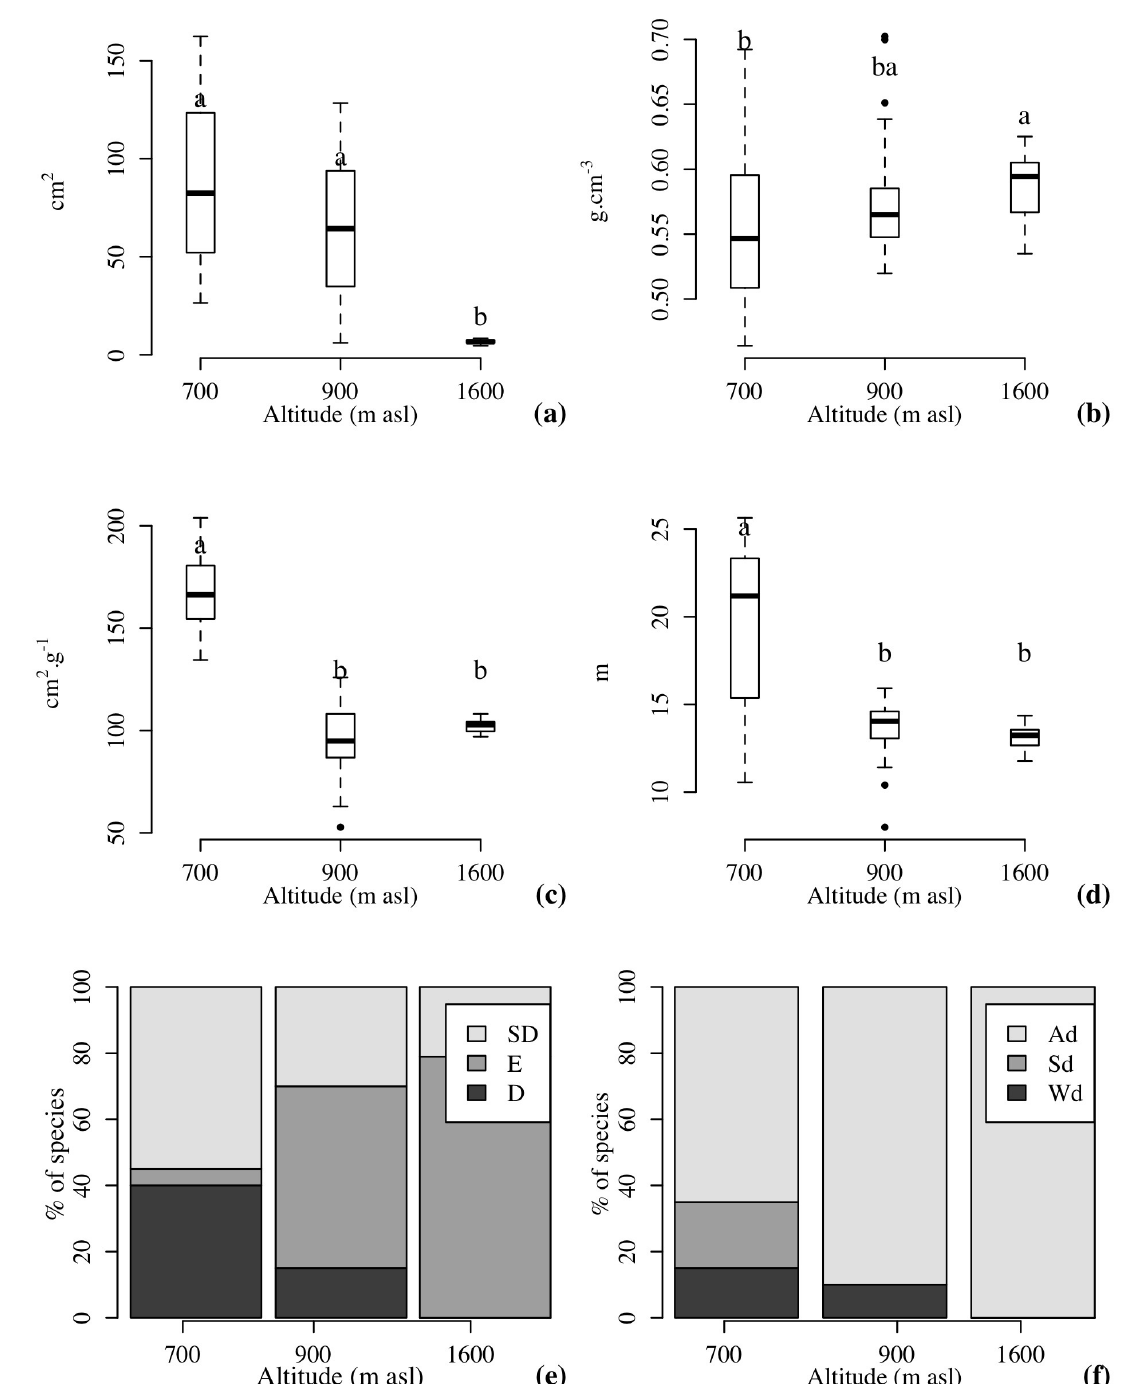
Figure 3 - Comparison of functional traits of tree species ( a - Leaf Area; b - Basic Wood Density; c - Specific Leaf Area; d - Maximum Potential Height; e - Pattern of Leaf Renewal; and f - Dispersal Guilds) in araucaria forest areas, over an altitudinal gradient, along the southern plateau of Santa Catarina, Brazil. Boxplots followed by different letters present significant differences by nonparametric post hoc tests for multiple comparison (SD = semi-deciduous; D = deciduous; E = evergreen; Sd = self-dispersed; Wd = wind-dispersed; Ad =